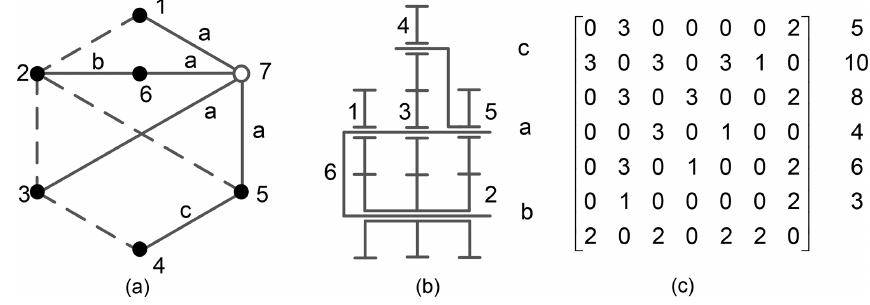
Figure 4. Double planet carrier gear train. (a) The d graph, (b) mechanism diagram, and (c) the adjacency matrix of the d